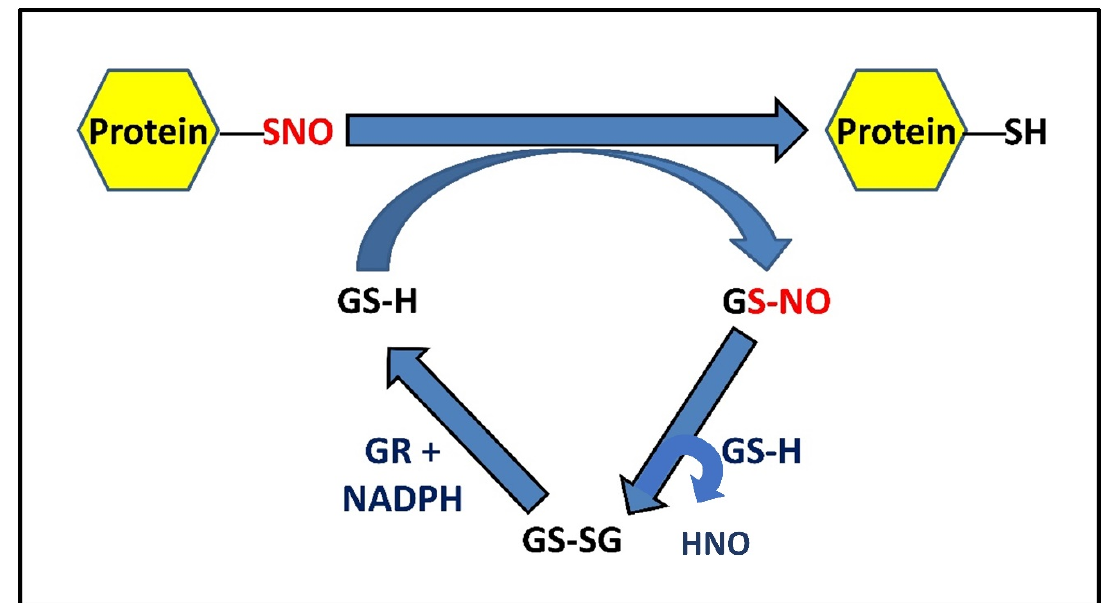
Figure 2. Mechanism of GSH-mediated denitrosylation of PSNOs. S-nitrosylated proteins can be denitrosylated by reduced glutathione (GSH), forming protein with reduced thiol(s) and GSNO, which is metabolized by ubiquitously expressed GSH into a stable disulfide form (GSSG) at the expense of HNO. GSSG (oxidized GSH) can be further reduced back to GSH by NADPH-dependent GR. Alternatively, GSNO can also be irreversibly metabolized by GSNOR to a complex N-hydroxysulphenamide (GSNHOH) form, utilizing reducing equivalents from NADH [3,42].